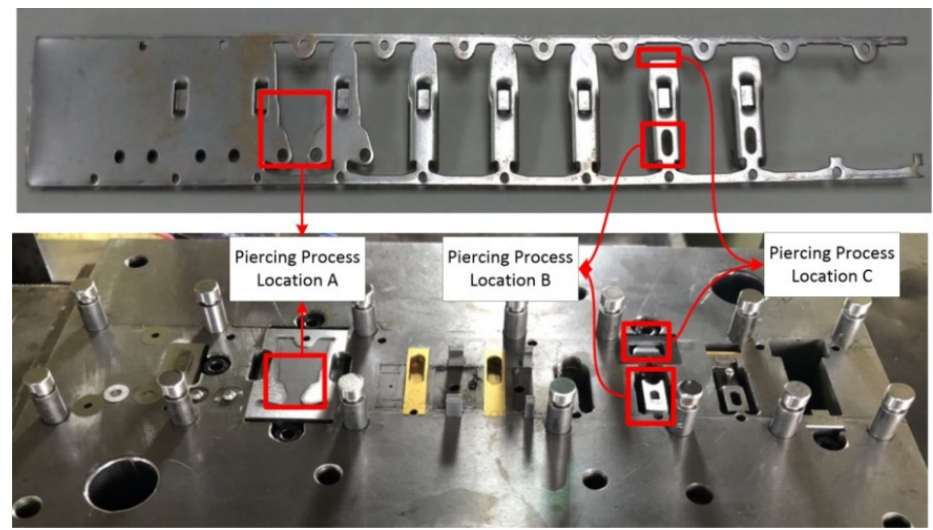
Figure 5. Monitored locations of the tool die. Data preprocessing was conducted for each vibration sample. First, each data sample was converted from time-based to frequency-based (frequency = 12.8 kHz). Second, each converted sample was normalized. The data transformation is presented in Figure 6.